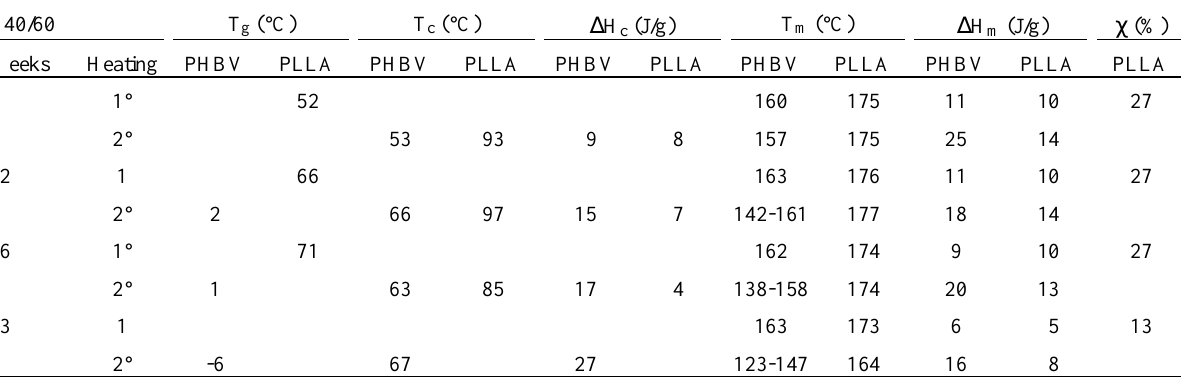
Table 4. Glass Transition (T g ), Crystallization (T c ) and Melting (T m ) Temperatures; Crystallization ( ∆ H c ) and Melting ( ∆ H m ) Enthalpies;